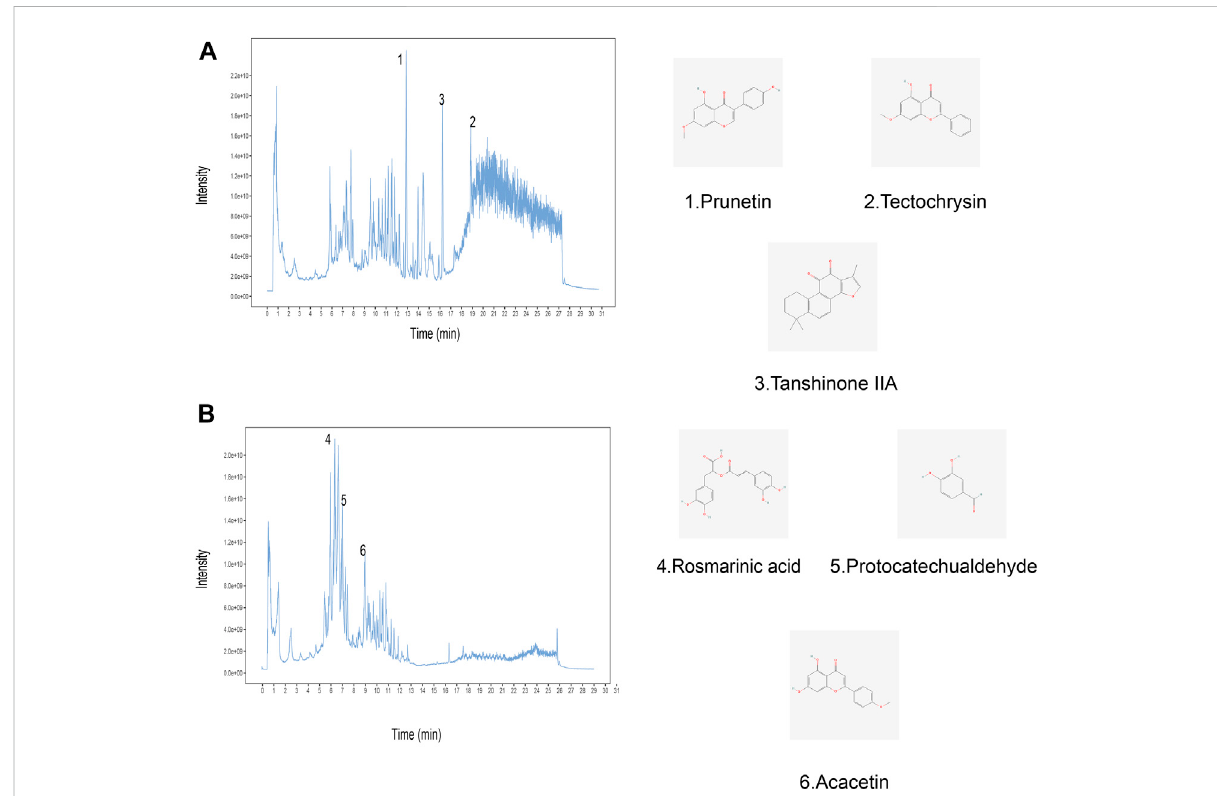
the Supplementary Table S1 for detailed ingredient